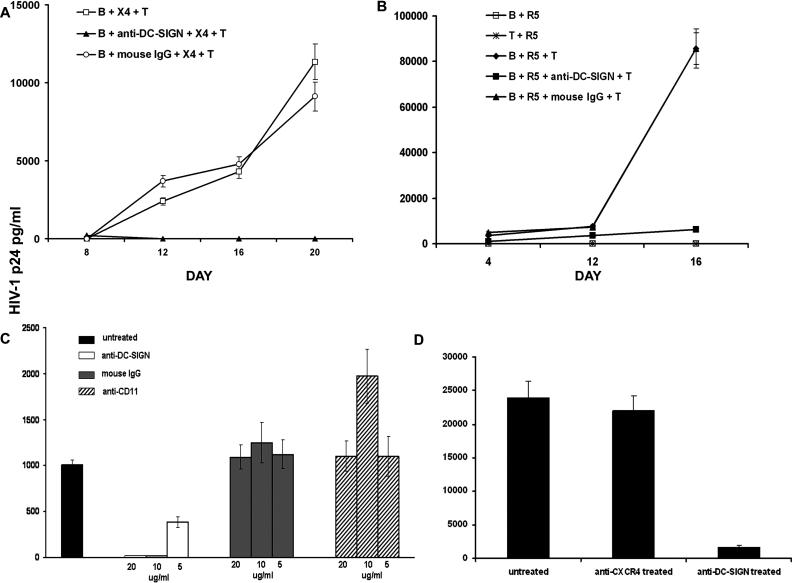
B Cell–Mediated Transmission of HIV X4 and R5 to T Cells Is Blocked by Anti–DC-SIGN mAb(A) and (B) HIV-1 p24 levels in cultures of activated B cells that were treated with anti–DC-SIGN mAb, incubated with either HIV-1 X4 (IIIb) (Figure 6A) or R5 (Ba-L) (Figure 6B) for 2 h at 37 °C, washed and co-cultured with autologous T cells. B and T cells cultured alone with each virus were used as controls.(C) HIV-1 p24 levels in cultures of activated B cells that were incubated with decreasing amounts of anti–DC-SIGN mAb prior to exposure to HIV-1 R5 (Ba-L) and culture with autologous T cells for 8 d. Treatment with mouse IgG or an unrelated mAb (anti-CD11a) had no effect on HIV-1 R5 (Ba-L) trans infection.(D) HIV-1 p24 levels in cultures of activated B cells incubated with anti–DC-SIGN mAb or anti-CXCR4 mAb, washed, loaded with HIV-1 X4 (IIIb), and co-cultured with autologous T cells for 12 d.Data are represented as mean of triplicates ± SE. Data are from single experiments representative of eight independent experiments.